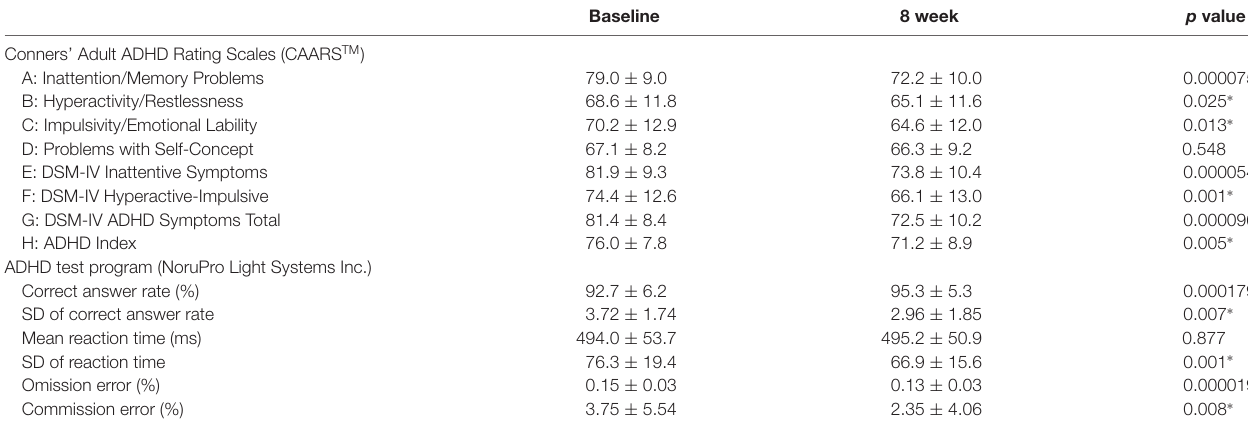
TABLE 1 | Scores of Conners’ Adult ADHD Rating Scales and ADHD test program.